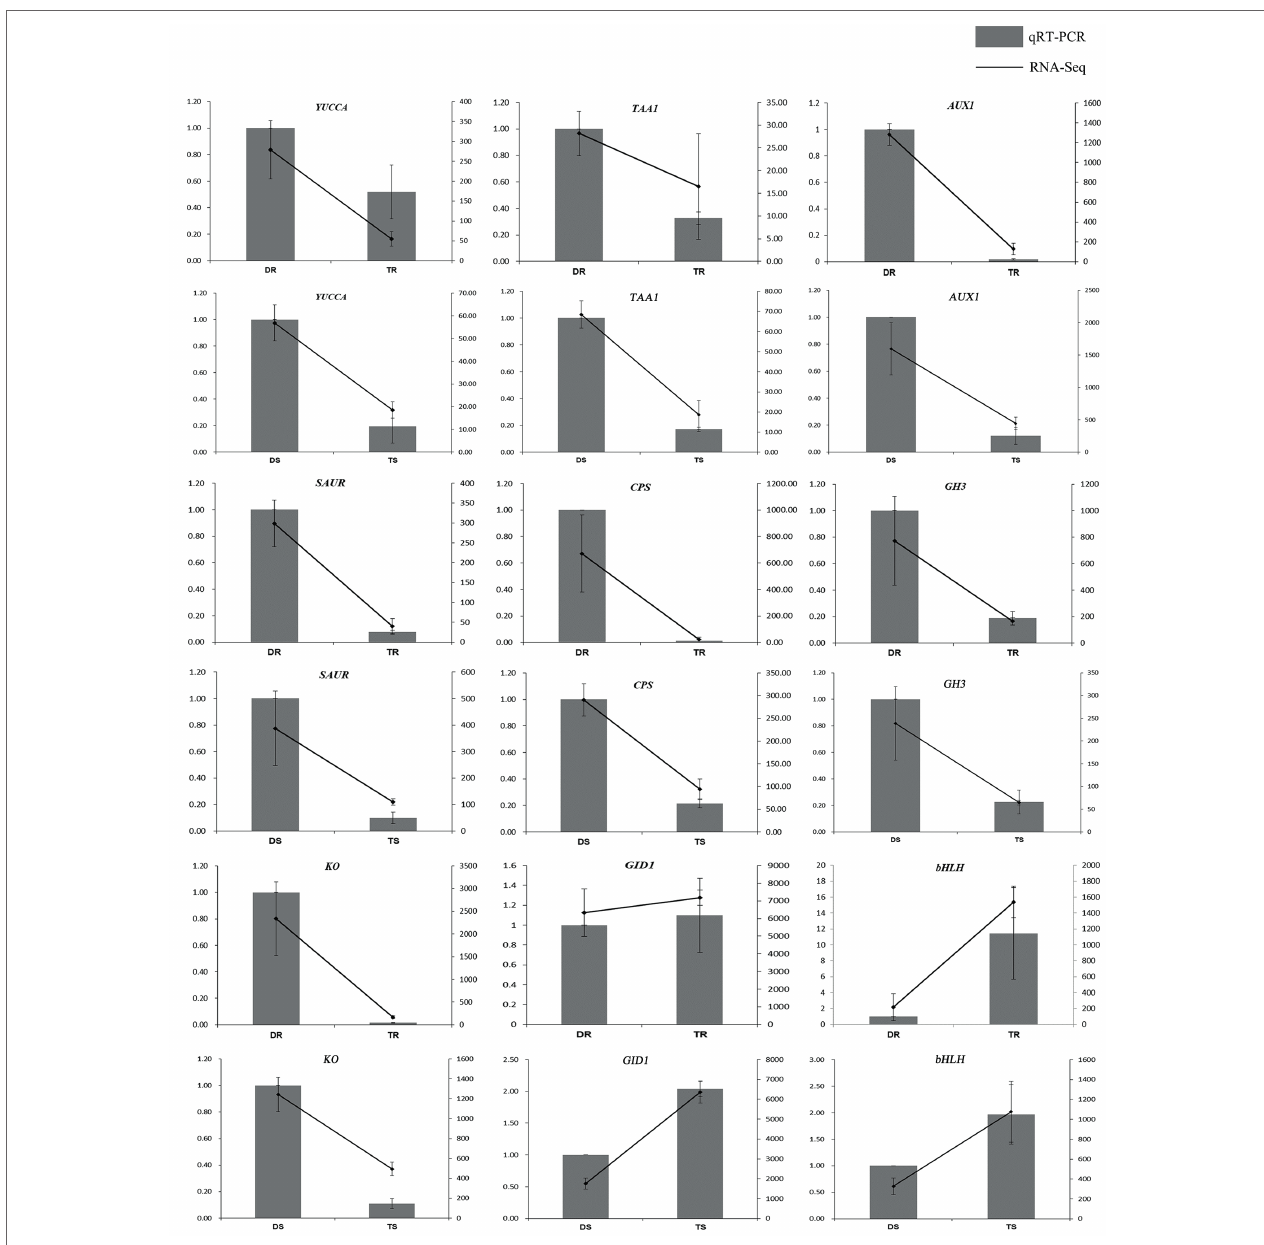
FIGURE 5 | Comparison of expression profiles of nine representative genes as measured by RNA-seq and qRT-PCR. Columns represent expression determined by qRT-PCR (left y-axis), while lines represent expression by RNA-seq in FPKM values (right y-axis). The x-axis in each chart represents different plant materials. For qRT-PCR assay, the mean was calculated from three biological replicates each with three technical replicates ( n = 9). For RNA-seq, each point is the mean of three biological